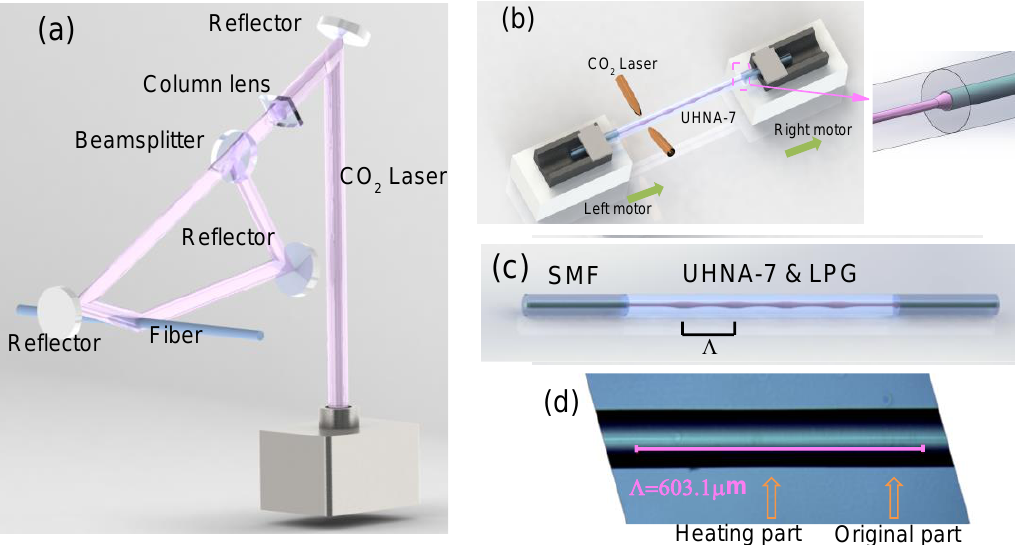
Figure 1. ( a ) The schematic illustration of the optical path in the LZM-100. ( b ) Formation of an LPFG on a UHNA-7 fiber with a CO 2 laser splicer. ( c ) The structure of the LPFG on the UHNA-7 fiber. ( d ) The side image of the LPFG under a microscope.